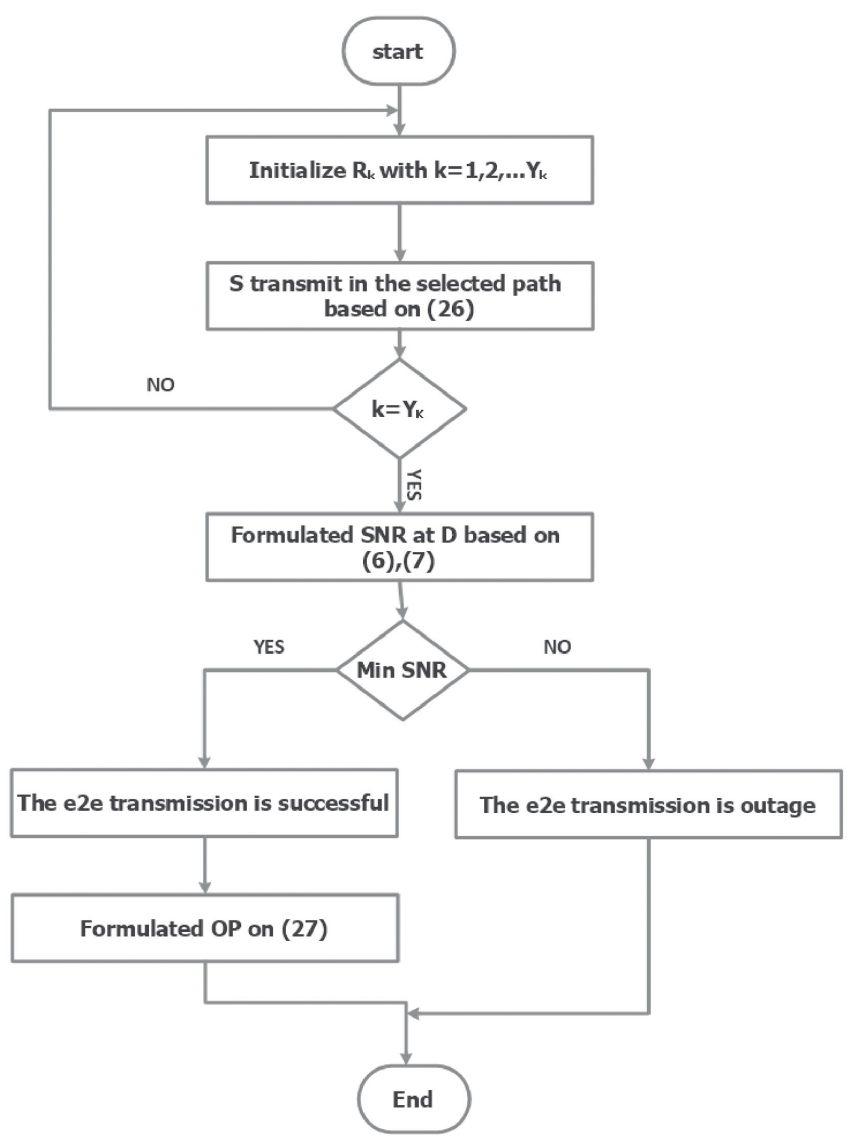
Fig 2. The flow chart for the data transmission of (MMPS)